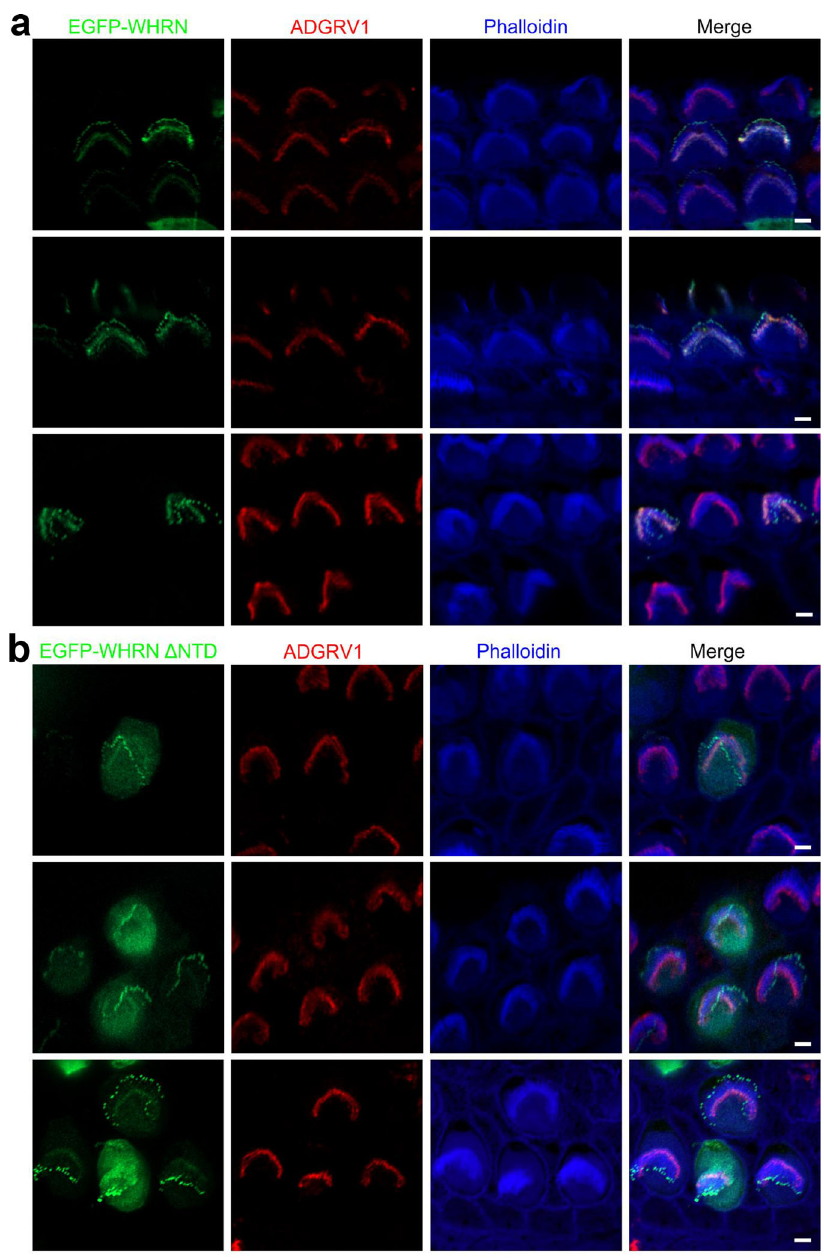
Fig. 7 | NTD is necessary for WHRN to target the ankle region of stereocilia. Cochlear explants from P4 wild-type mice were injectoporated with expression vectors to express EGFP-tagged full-length WHRN ( a ) or WHRN lacking NTD ( b ) in